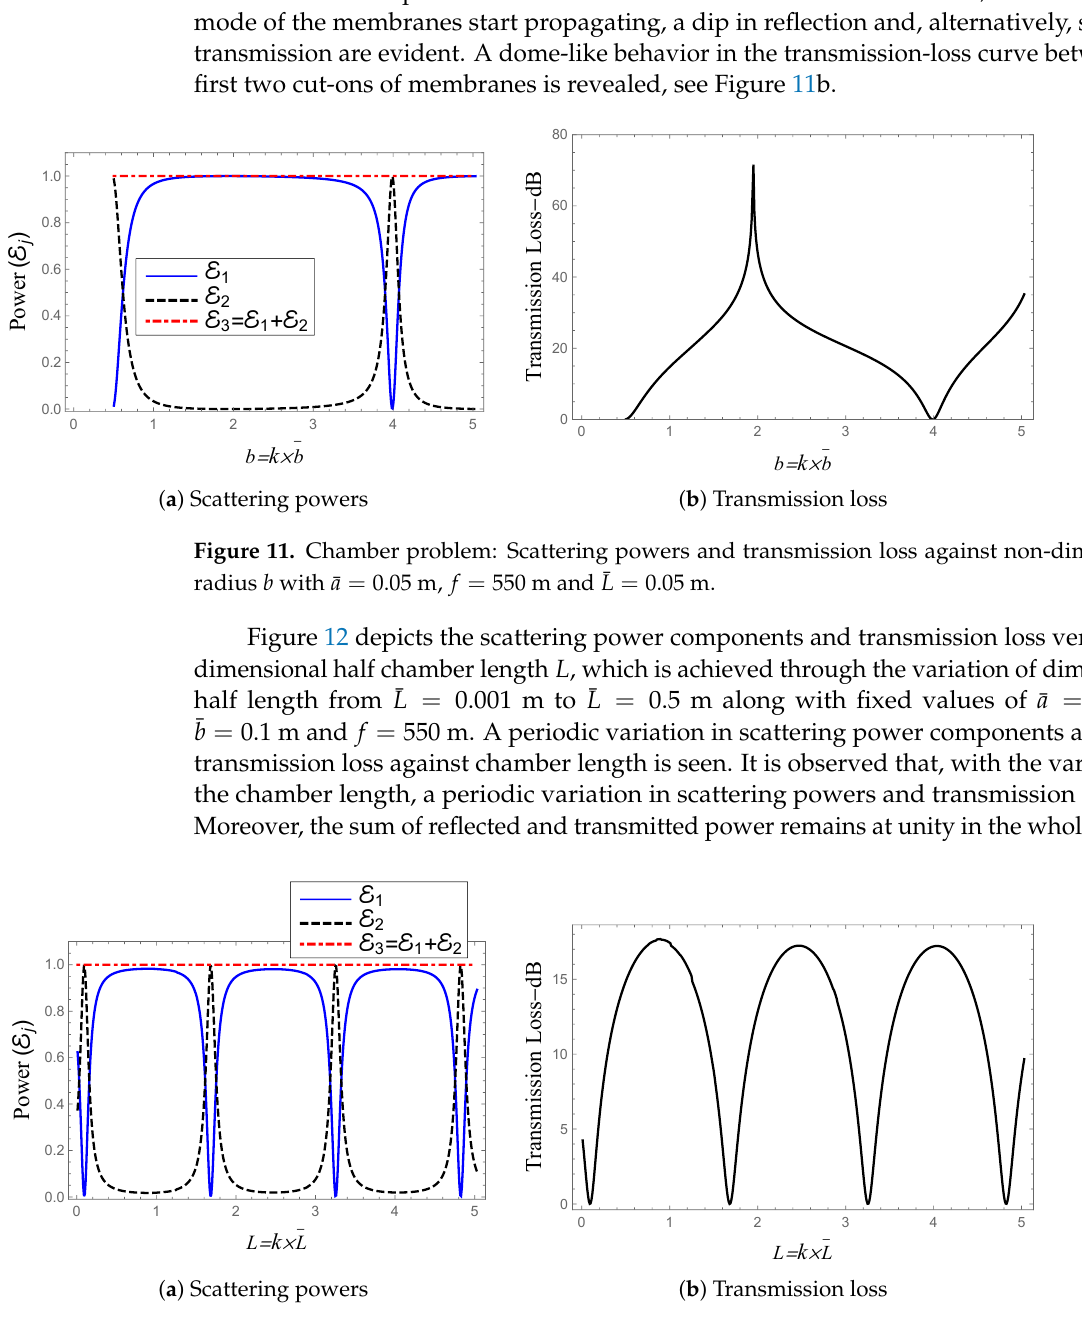
Figure 12. Chamber problem: Scattering powers and transmission loss against non-dimensional half chamber length L with ¯ a = 0.05 m, f = 550 m and ¯ b = 0.1